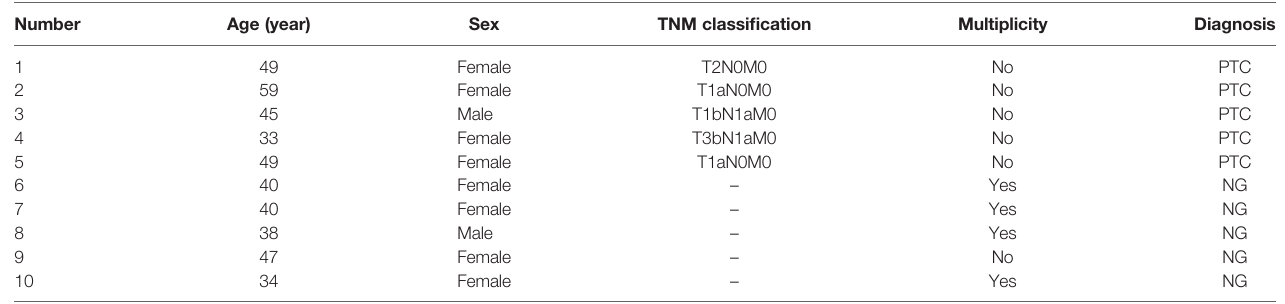
TABLE 1 | Detailed information of characteristics of study samples used in